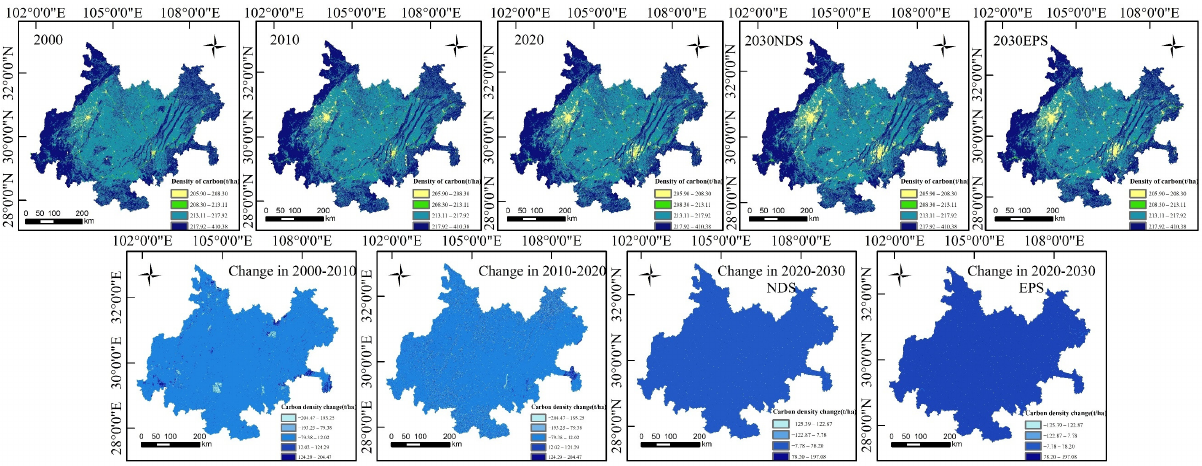
Figure 6. Carbon storage and its changes over different periods.